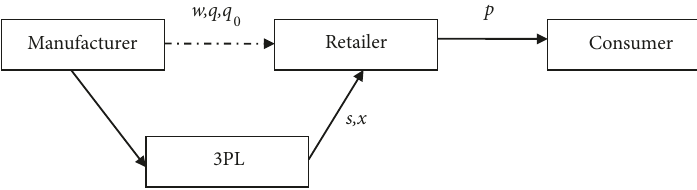
Figure 1: The relationship among supply chain members when including the logistics service